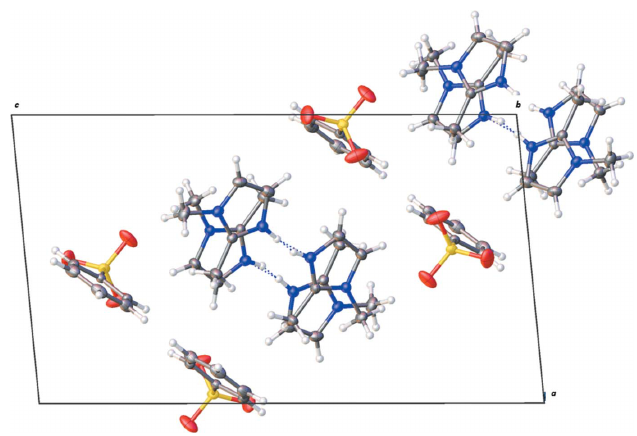
Figure 2 Packing diagram of the title compound viewed down the (010) plane showing a layered network of ion pairs held together through hydrogen interactions. Both parts of the disorder are shown.